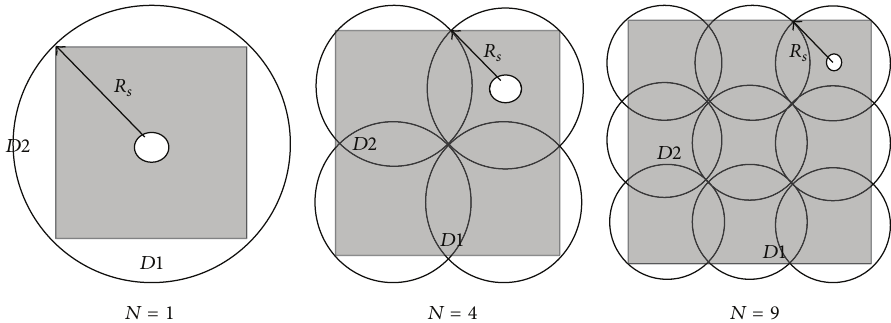
Figure 8: Diagrammatic sketches of 𝐷1 and 𝐷2 when 𝑁 = 1, 4,9